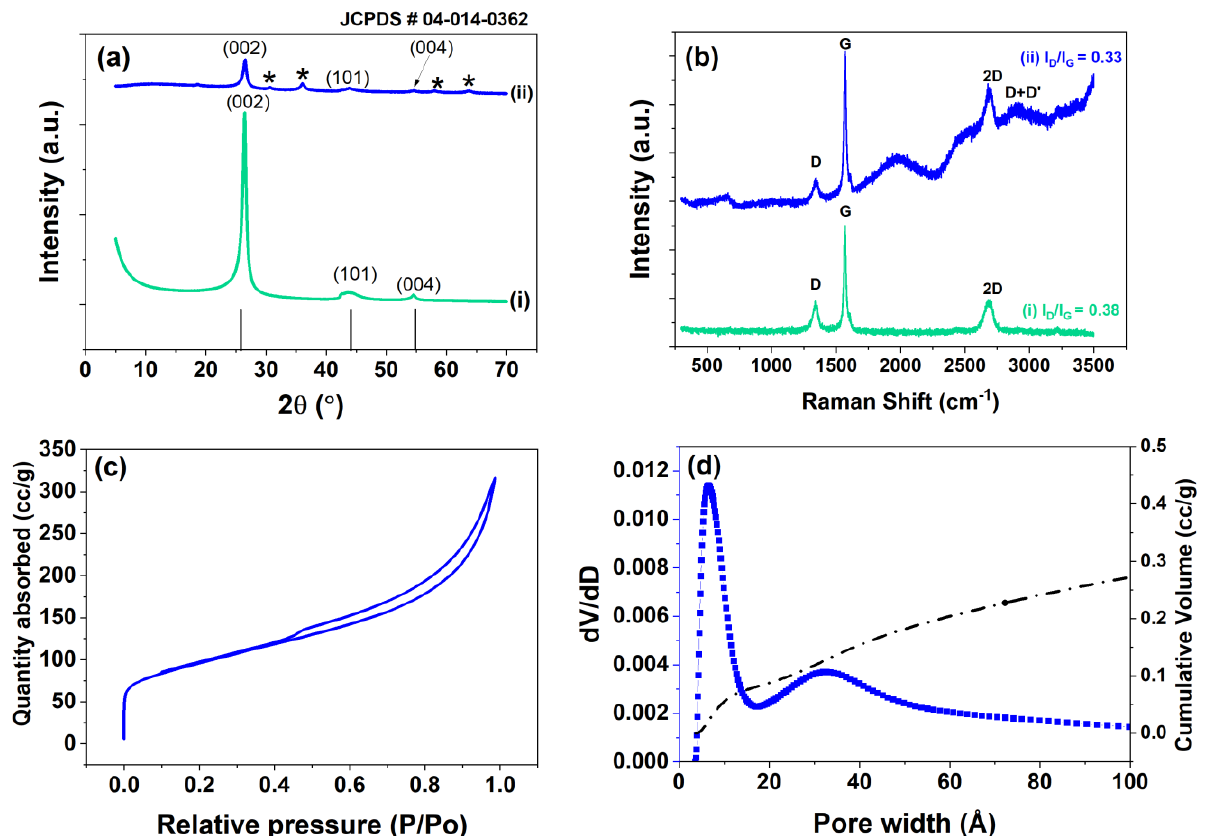
Figure 3. XRD patterns of edge - oxidized GO (i) and CoO x - Fe 3 O 4 /N - rGO (ii) ( a ), Raman spectra of